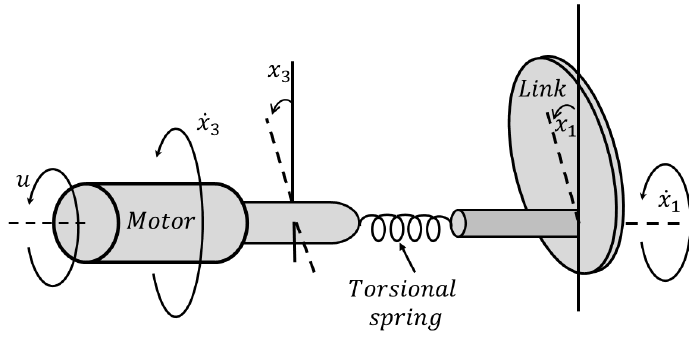
Figure 1. A single-link flexible joint manipulator.